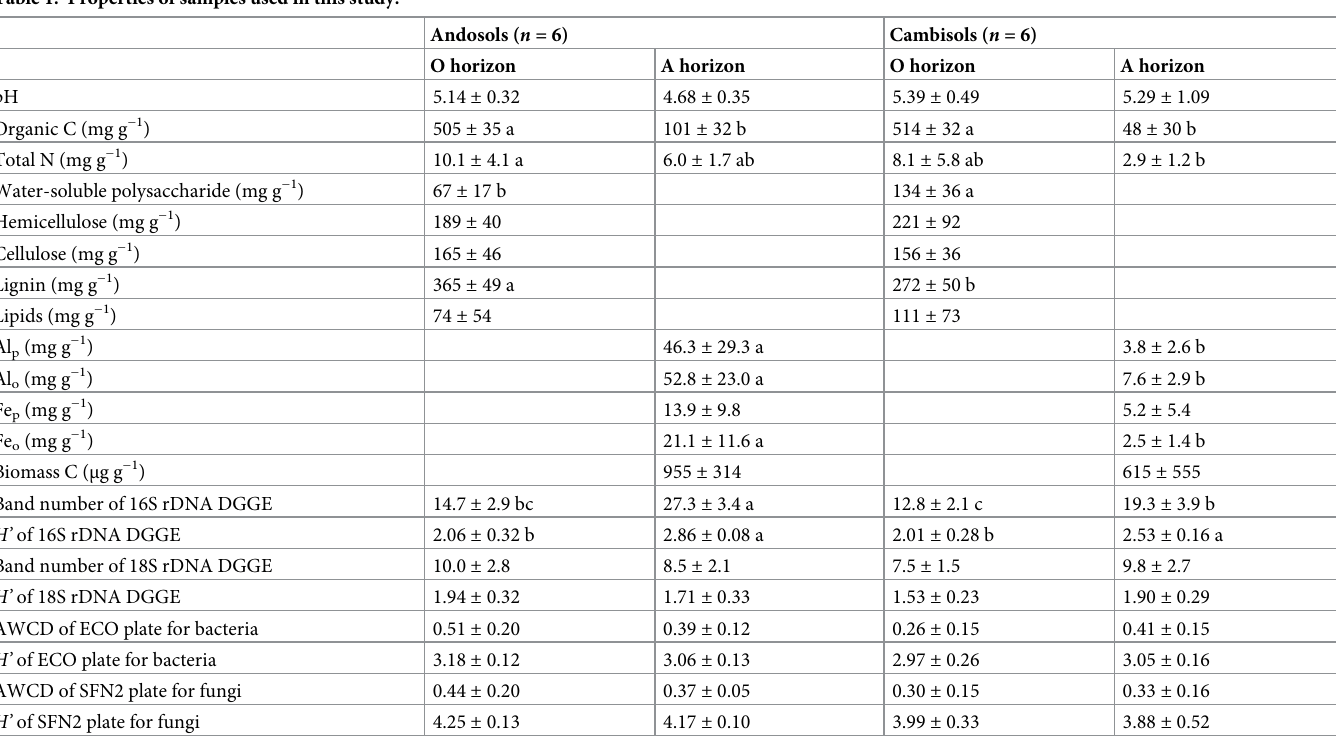
Table 1. Properties of samples used in this